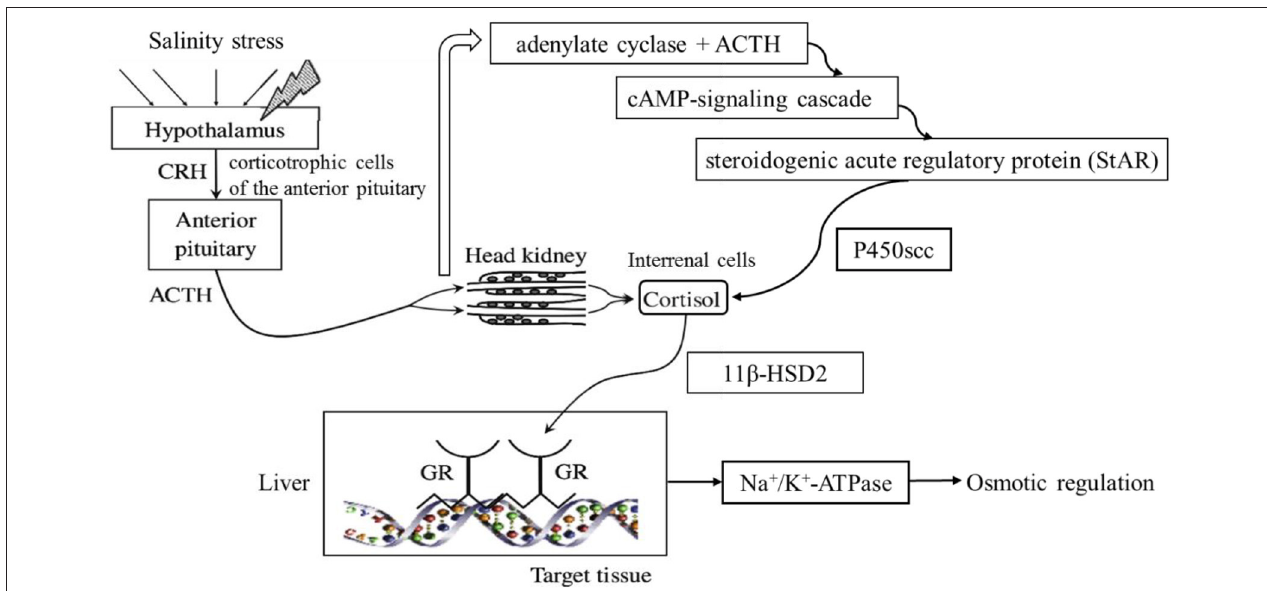
FIGURE 1 | Conceptual pathways of the influence of dietary cholesterol. Upon exposure to a stressor, the hypothalamus secretes CRH in the area of the corticotropic cells of the anterior pituitary. In response, the corticotrophs secrete adrenocorticotropic hormone derived from proopiomelanocortin (ACTH) to the circulation, which stimulates cortisol synthesis and secretion from the interrenal cells of the head kidney in fish. The ACTH binding with adenylate cyclase stimulates the cAMP-signaling cascade. The StAR limits the transportation of cholesterol, and the P450scc restricts the conversion from cholesterol to cortisol. Cortisol binds to the GR and regulates the expression of Na + /K + -ATPase, which is involved in